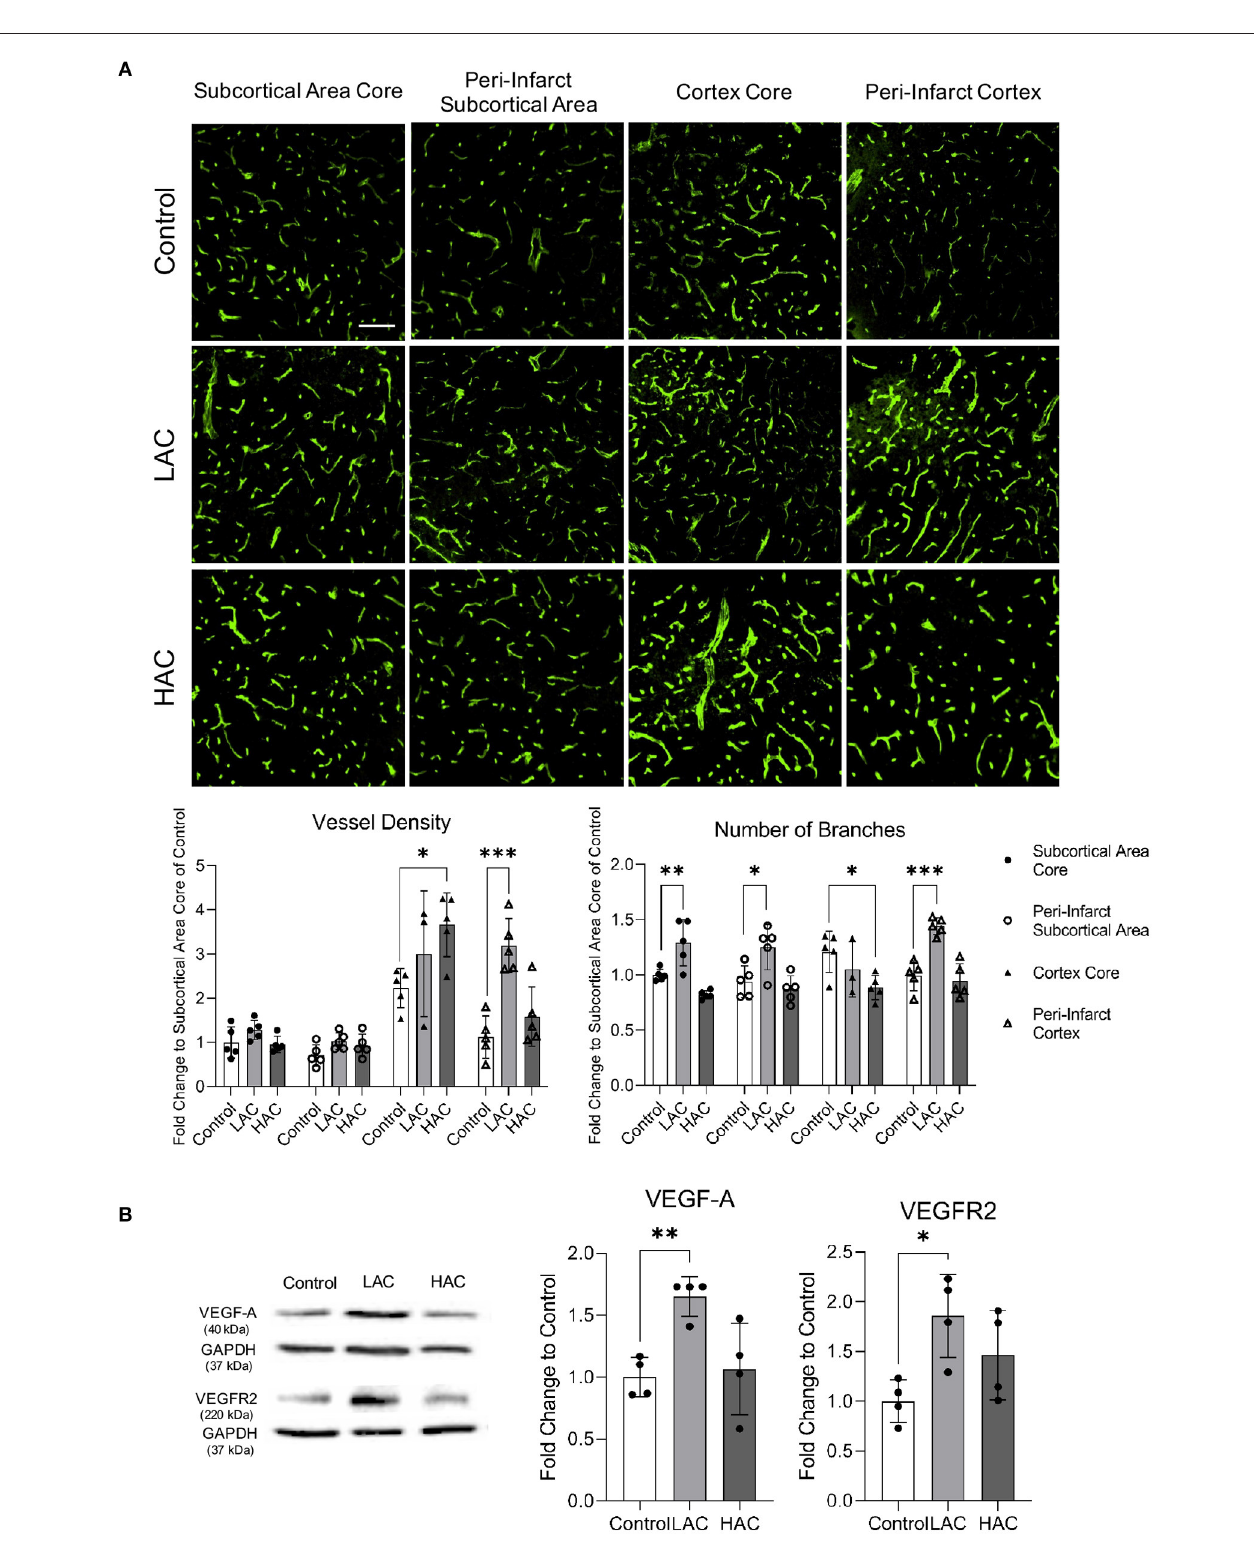
FIGURE 4 | Effect of chronic alcohol consumption on cerebral angiogenesis at 72h of reperfusion following a 60-min transient focal cerebral ischemia. (A) Representative images of CD31 staining (upper) (scale bar = 100 µ m). Values are means ± SD (lower, n = 5). (B) Representative Western blots of VEGF-A and VEGFR2 (left). Values are means ± SD (right, n = 4). * P < 0.05, ** P < 0.005, *** P < 0.0005 vs. Control. Analyzed using one-way ANOVA with Dunnett’s post-hoc .